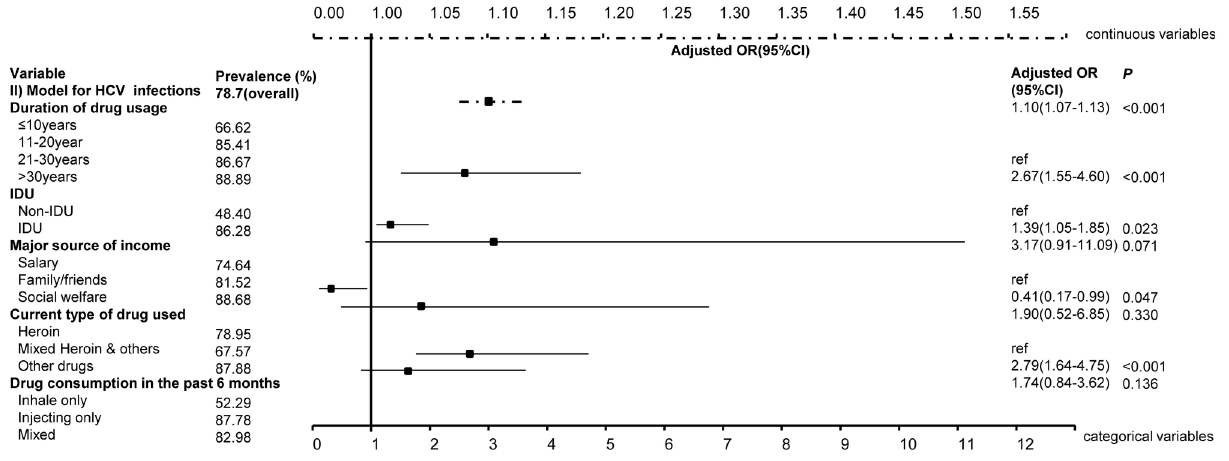
Figure 2. Significant associated factors for HCV infections among MMT entrants by multivariate regression analysis. The figure demonstrates the adjusted odds ratios (together with 95% confidence intervals) of factors that are significant associated with HCV infections among MMT entrants. The top dashed line denotes the scale for the continuous variables, whereas the bottom solid line denotes that for categorical variables.